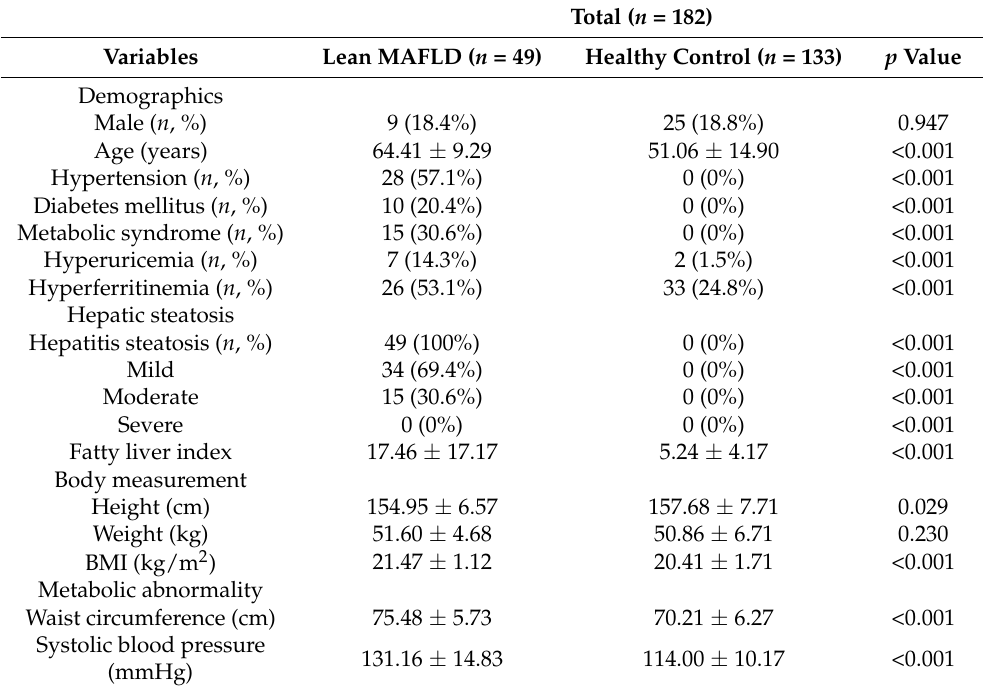
Table 1. Baseline demographic and biochemical characteristics of study subjects.